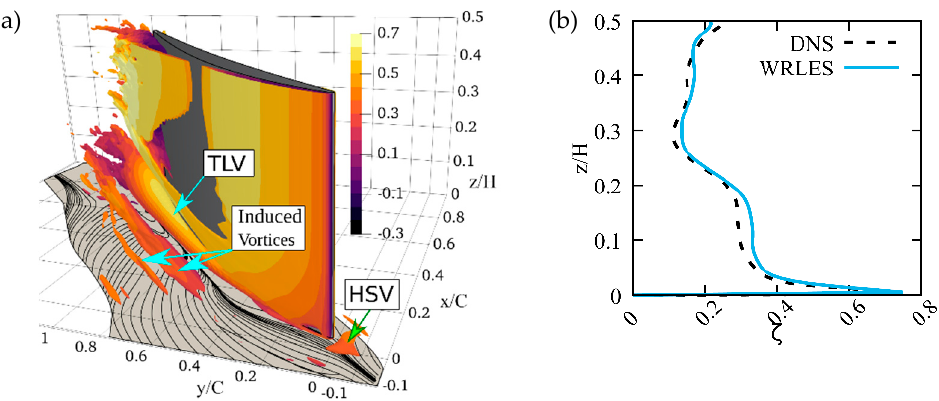
Figure 7. Linear compressor cascade at Re C = 1.46 · 10 4 . ( a ) Vortical structure visualized through → λ 2 ( (cid:104) v (cid:105) ) = − 2. ( b ) Pitchwise averaged total pressure losses downstream of the blade at x/C = 0.89.